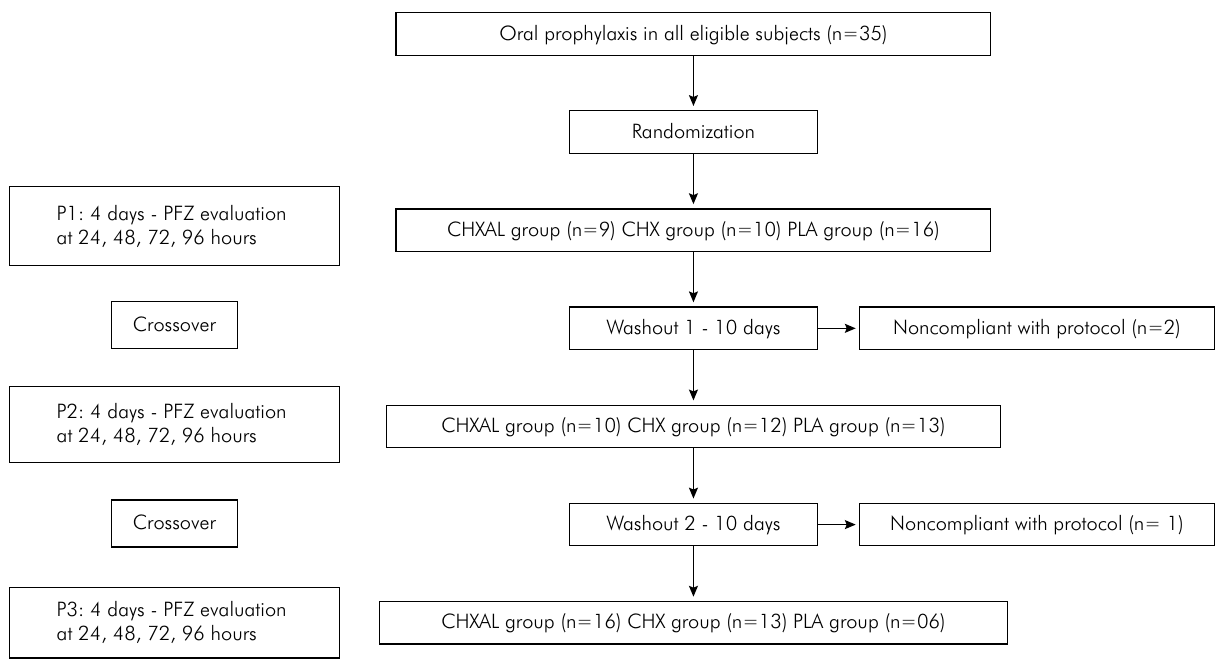
Figure 1. Study flow diagram. (P1, period one; P2, period two; P3, period three; PFZ, plaque free zone; PLA, placebo; CHXAL, alcohol-containing chlorhexidine; CHX, alcohol-free